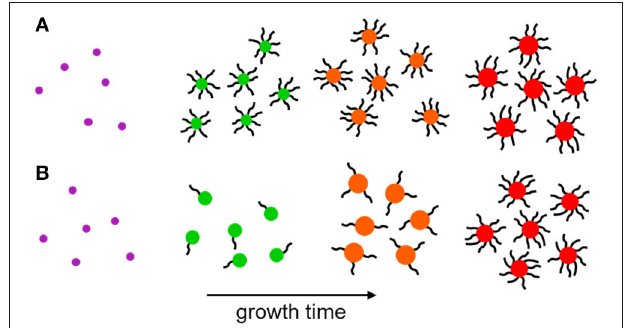
FIGURE 1 | Schematic of NC growth. (A) Following LaMer nucleation the immature NCs are well-capped by surface ligands throughout most of their subsequent growth. (B) Nascent NCs nucleate following the same LaMer-type mechanism, but surface ligation occurs primarily after NC growth. A terminal ligation stage is proposed in literature for CdSe and MAPbI 3 NCs and is supported by the measurements in this